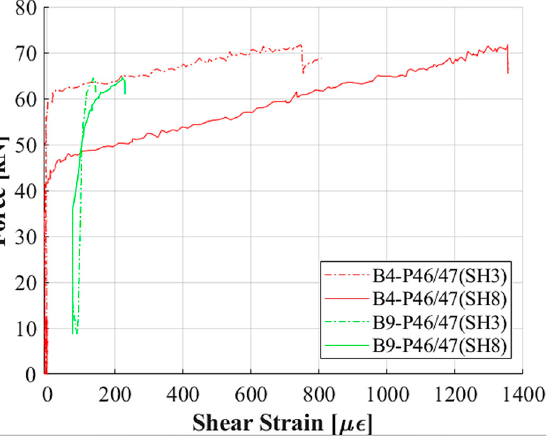
Figure 20. Force–tensile shear strain for SH3 and SH8 for the B4-P47/46 and B9-P47/46 beams.